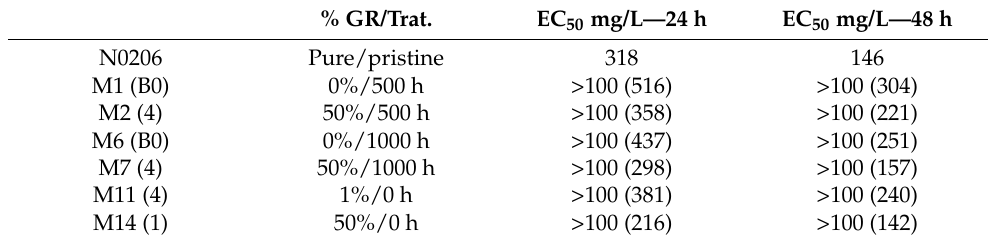
Table 7 depicts the effect concentration levels (EC) for the samples analyzed. Table 7. Ecotoxicity measured as EC50 values at 24 and 48 h.